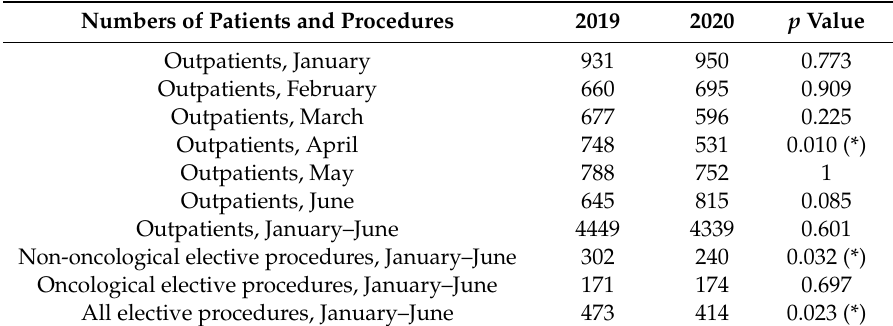
Table 1. Di ff erences between numbers of outpatients and of elective procedures at our neurosurgical department in the first half of 2019 as compared to the first half of